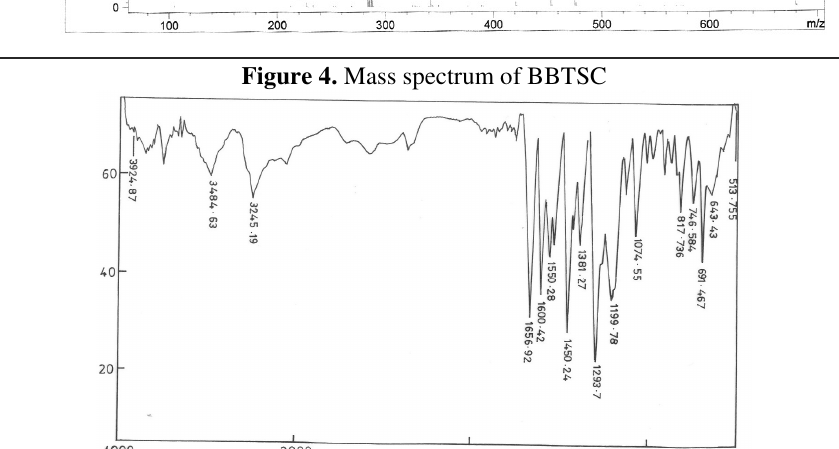
Figure 4. Mass spectrum of BBTSC